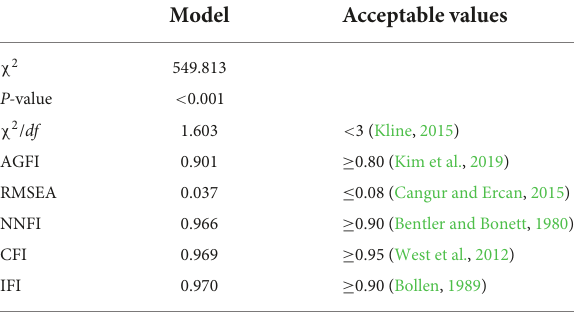
TABLE 6 Model fit